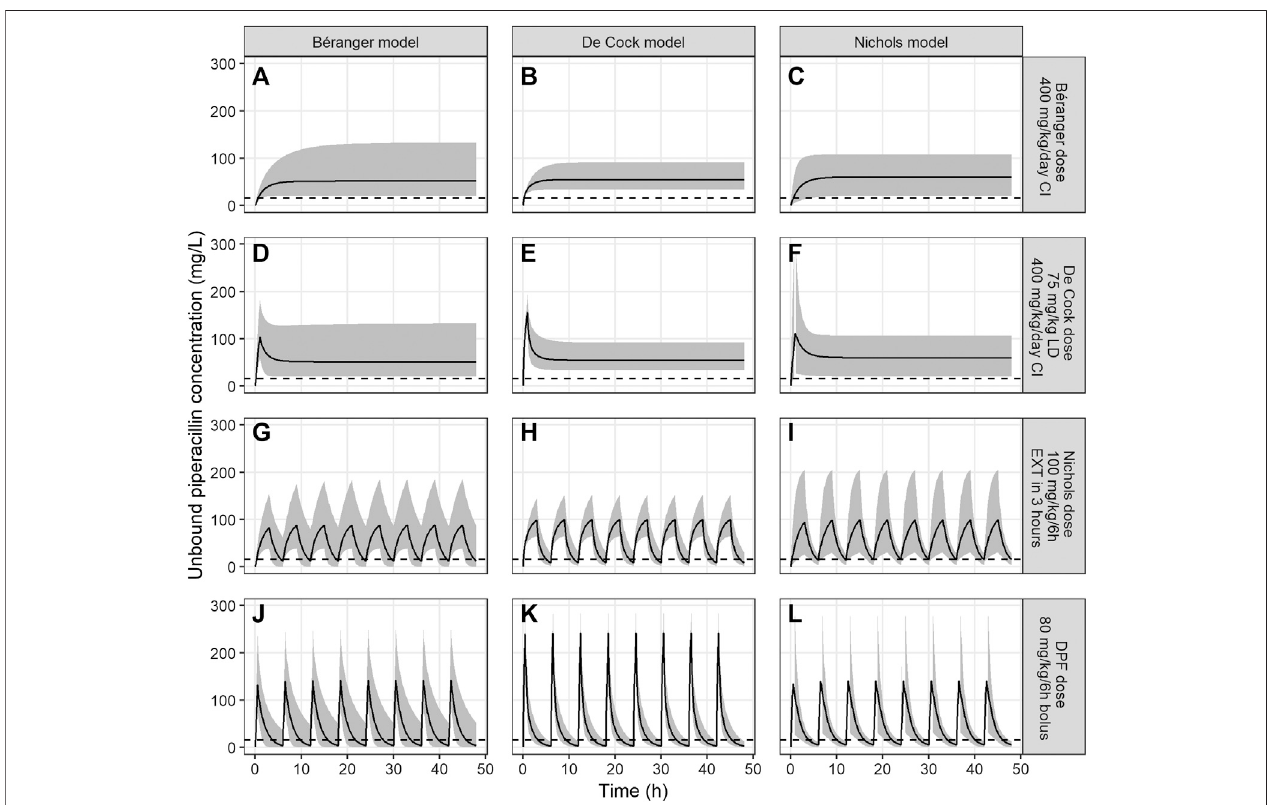
FIGURE 1 | Unbound piperacillin concentrations over 48 h for models of Béranger, De Cock and Nichols. The black line represents the median piperacillin concentration, the shaded grey area the 95% prediction interval, and the dotted line the target Cmin of > 16 mg/L. Columns represent the simulations of a single model (panel (A) , (D) , (G) and (J) fortheBérangermodel, panel (B) , (E) , (H) and (K) fortheDeCockmodelandpanel (C) , (F) , (I) and (L) forNicholsmodel).Therows represent differentdosingrecommendationsfromthedifferentmodels(panel (A) , (B) and (C) forthedoseproposedbyBéranger(400 mg/kg/dascontinuousinfusion),panel (D) , (E) and (F) for the dose proposed by De Cock (75 mg/kg loading dose +400 mg/kg/d as continuous infusion), panels (G) , (H) and (I) for the dose proposed by Nichols (100 mg/kg/6 h as extended infusion during 3 h) and panels (J) , (K) and (L) for the current DPF dose (80 mg/kg/6 h as bolus